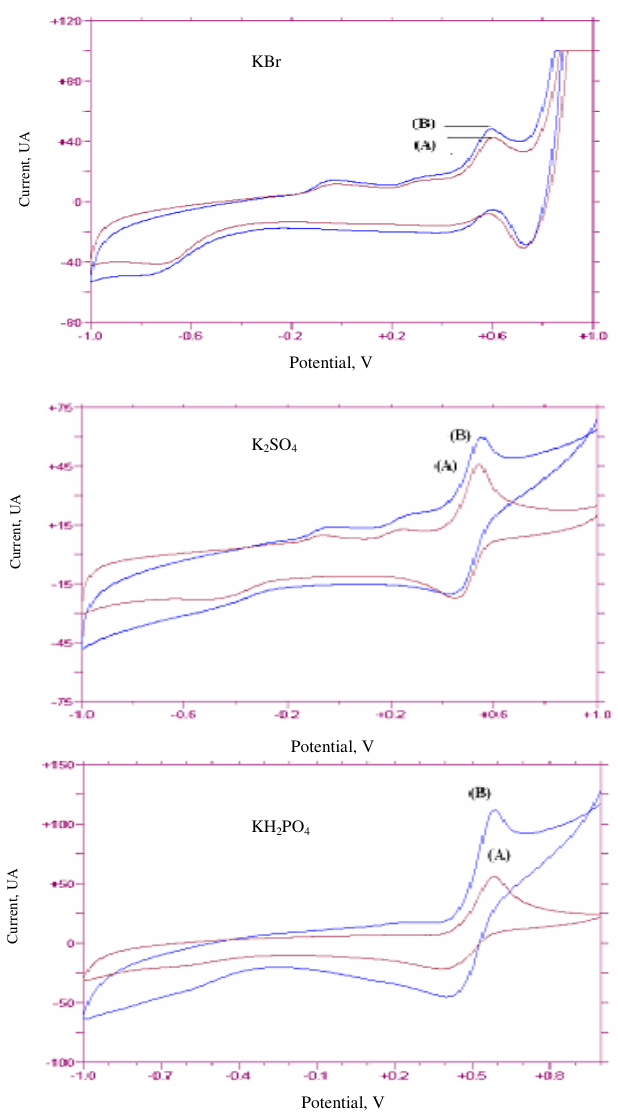
Figure 6. Tile graph (background subtracted) of the oxidation current of paracetmol at the in different supporting electrolytes at (a) bare GC electrode and (b) modified MgB a scan rate of 100 mV/